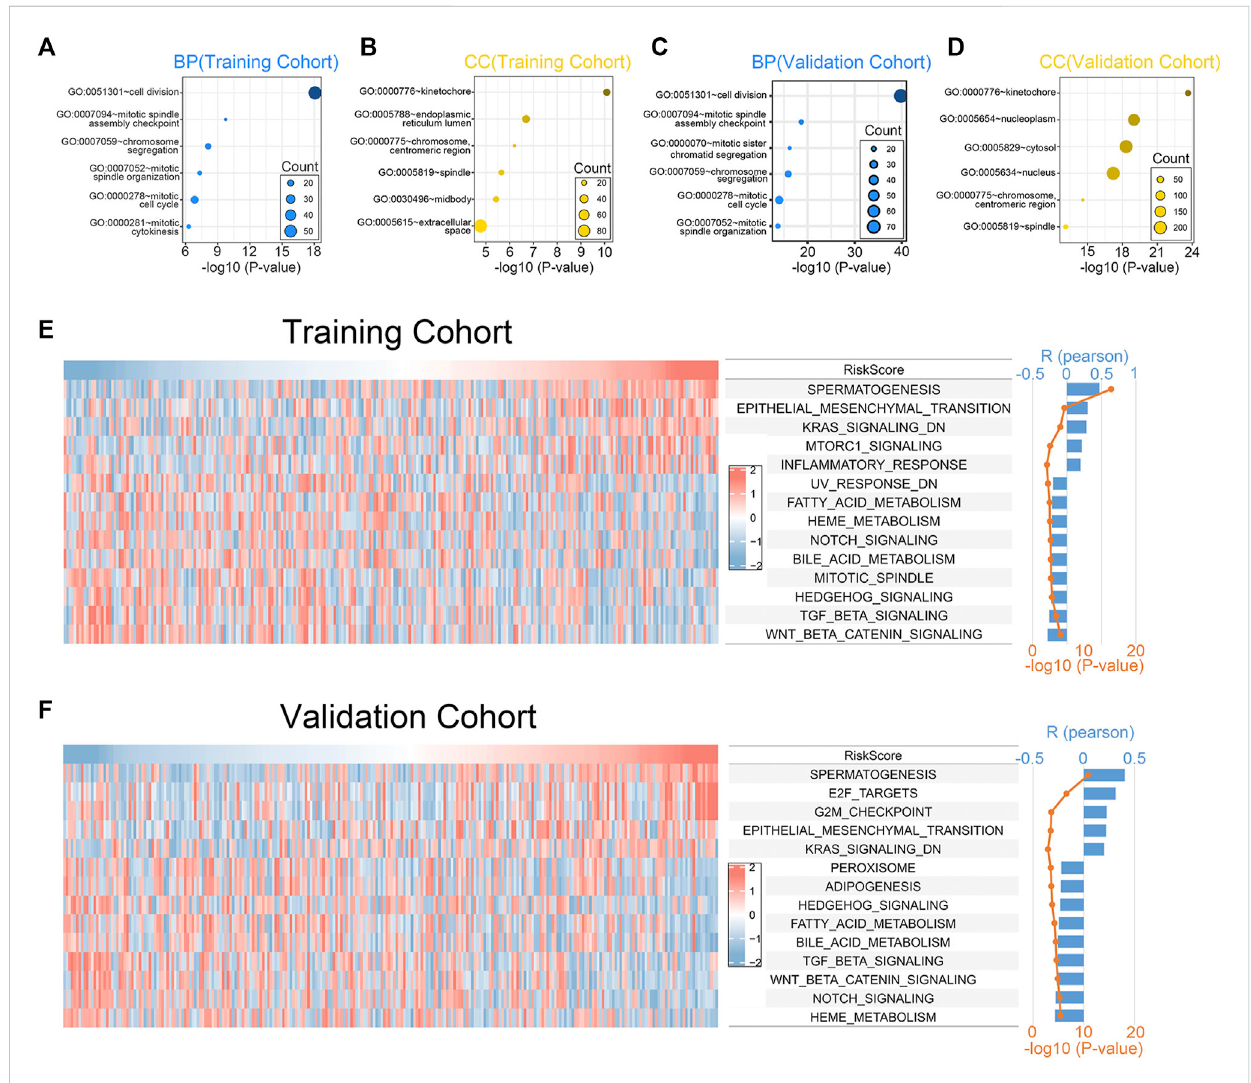
FIGURE 4 Biological functions associated with the 7-chemokine-genes signature. (A – D) The biological processes (BP) and cell components (CC) that are enriched by genes that are positively correlated with riskscore. (E, F) Correlation of riskscore with the HALLMARK gene set. The heat map shows the enrichment scores of the HALLMARK for each patient. Bar and line plots show R- and p -values for correlation